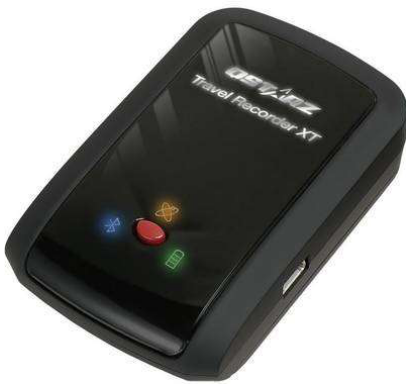
Figure 9. GPS receiver Qstarz BT-Q1000XT.